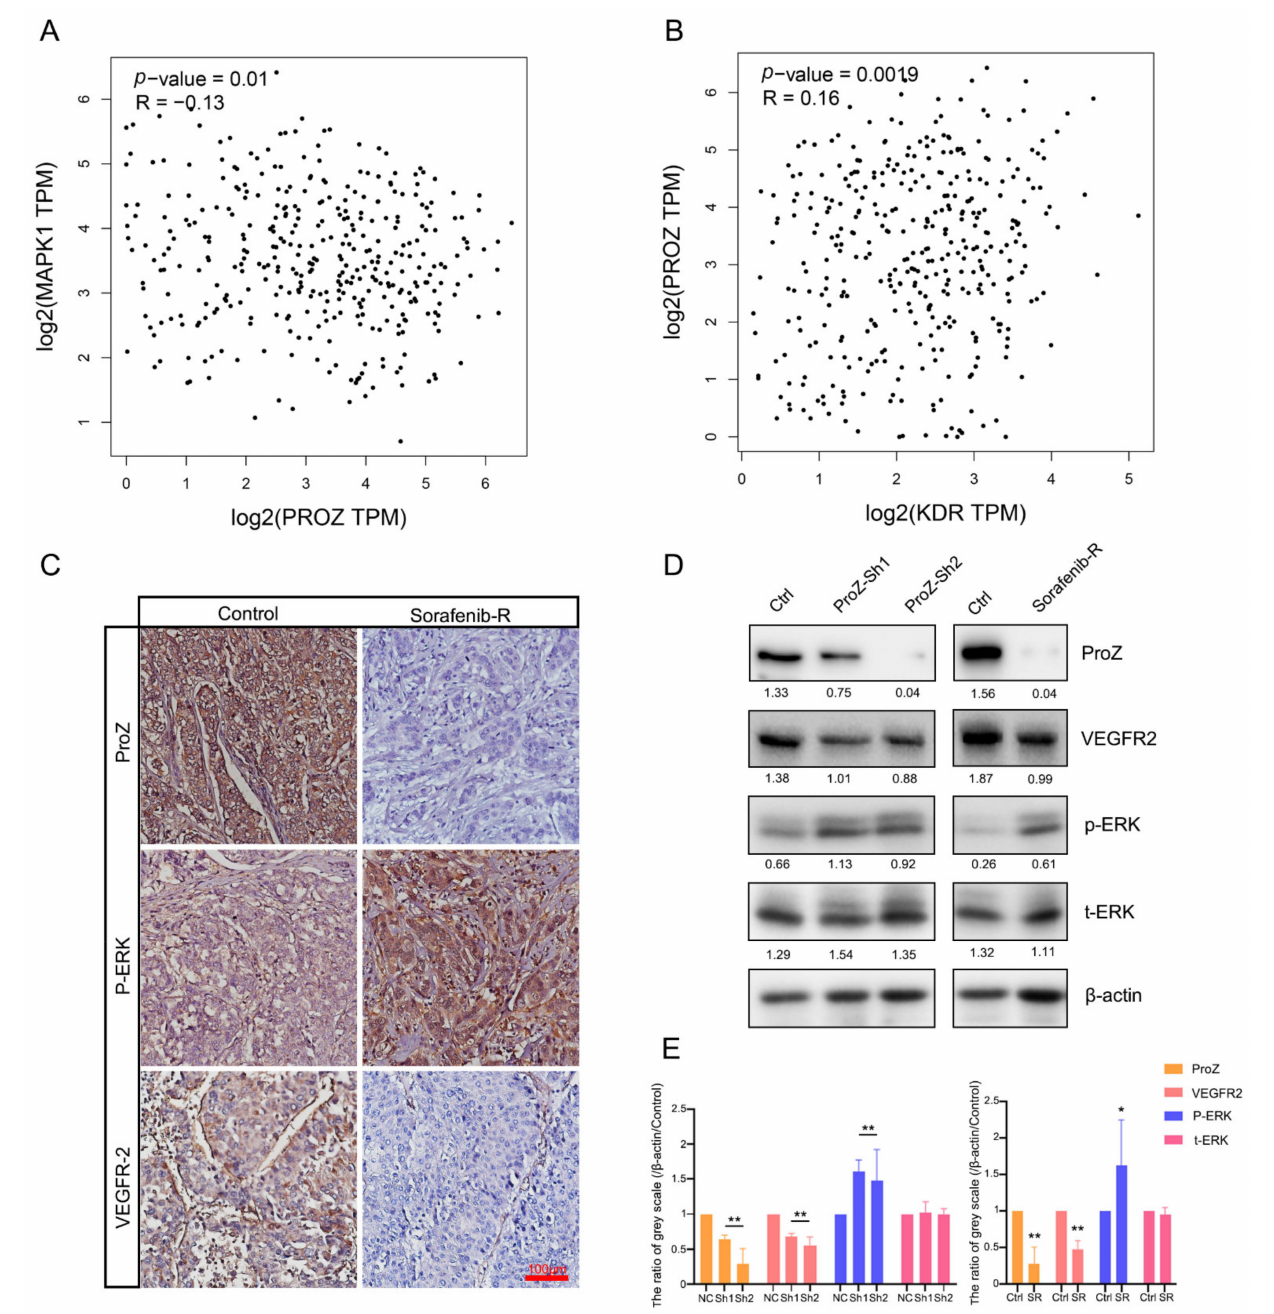
Figure 5. ( A ) Correlation between PROZ gene and MAPK1 gene was analyzed using TCGA data. ( B ) TCGA analysis of the correlation between PROZ and KDR. ( C ) Immunohistochemistry (IHC) staining showed expression changes of p-ERK and VEGFR2 in different expression PROZ of in HCC tumor. ( D ) Expression of p-ERK and VEGFR2 changes after PROZ interference in HCC cells or in sorafenib-resistant HCC cells; the values behind the bands are the ratio of grey scale (target protein compared with β -actin). ( E ) Statistical significance in the Western blot analysis; the grey scale values of the negative control (NC, ShRNA—negative control) and control (Ctrl, the HCC cells were not resistant to sorafenib) were set to 1, the ShRNA–PROZ (Sh1 and Sh2) and sorafenib-resistant cells (SR) were compared with the control group, respectively (Sh1 vs. NC, Sh2 vs. NC and SR vs. Ctrl; * p < 0.05; ** p <